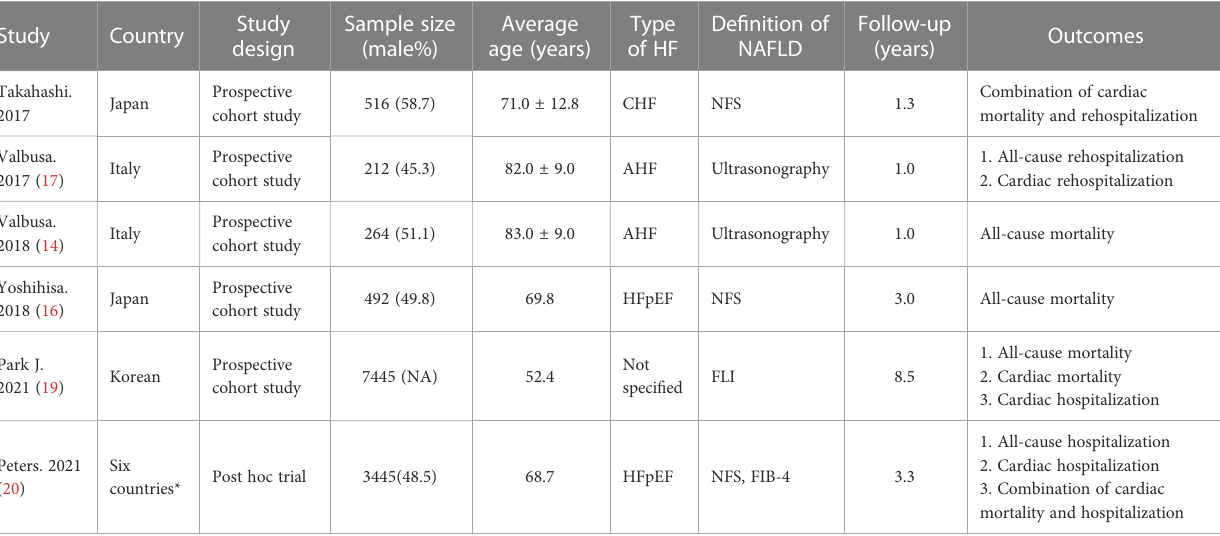
TABLE 1 Characteristics of the included studies.